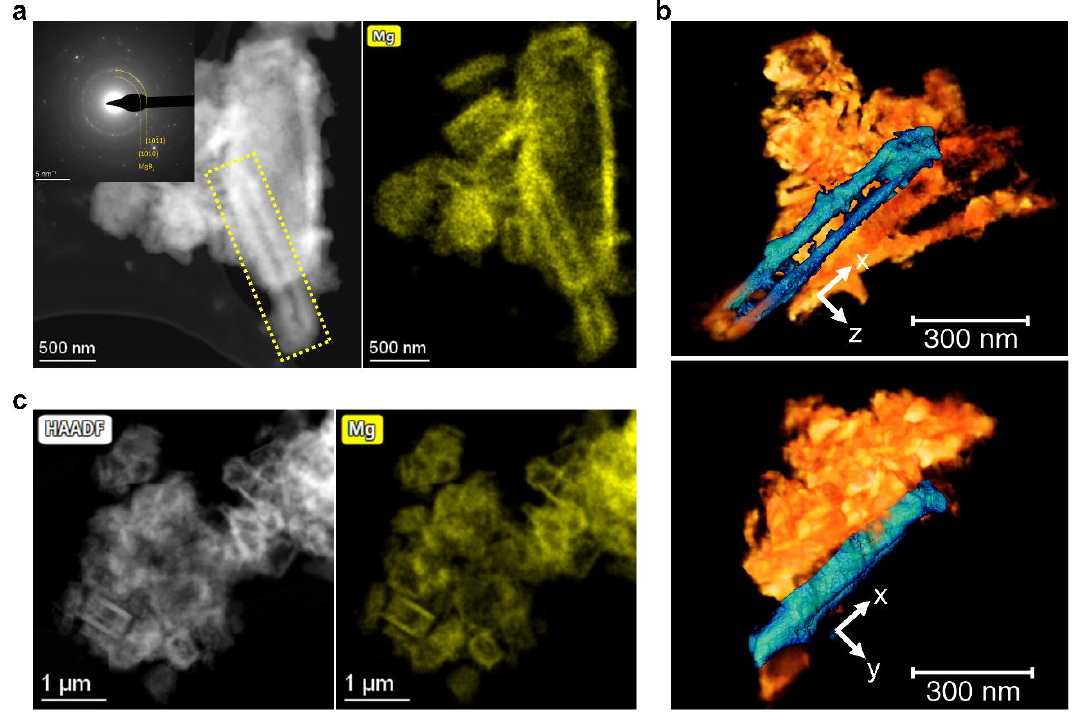
Figure 4. Desorbed 2LiBH 4 –MgH 2 with 1 mol% 3TiCl 3 • AlCl 3 : ( a ) STEM-HAADF image, and the corresponding DP and EDX elemental map of Mg (K lines), where shows a MgB 2 morphology similar to that of Figure 2; ( b ) Volume rendering from tomographic reconstruction of the parallel MgB 2 bars (highlighted in blue) of the following: ( c ) a STEM-HAADF image and the corresponding EDX map of Mg (K lines) showing the similar morphology of MgB 2 as that of Figure